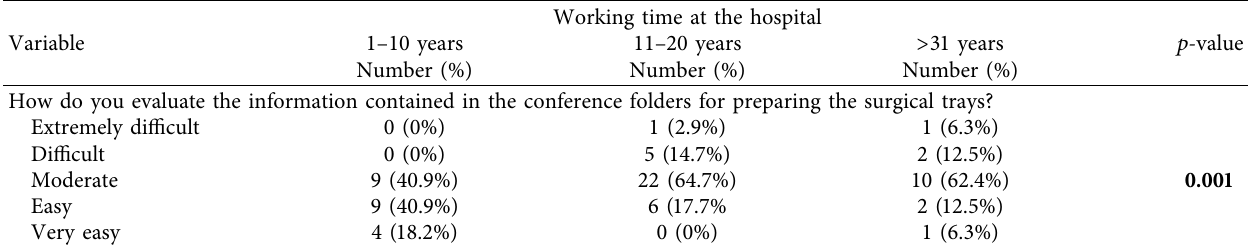
Table 5: Association between working time at the hospital and professional